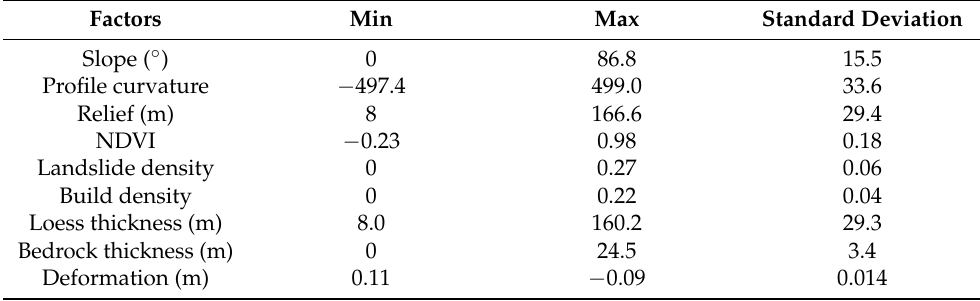
Table 1. Statistical description of the influencing